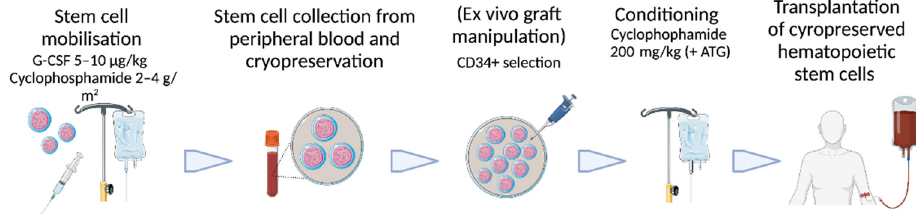
Figure 1. Procedural steps of autologous hematopoietic stem cell transplantation in autoimmune diseases with used drug dosing in studies for Crohn’s disease. G-CSF = granulocyte colony-stimulating factor; ATG = anti-thymocyte globulin. Figure created with Biorender.com and Smart Servier Medical Art. Accessed on 9 September 2022.